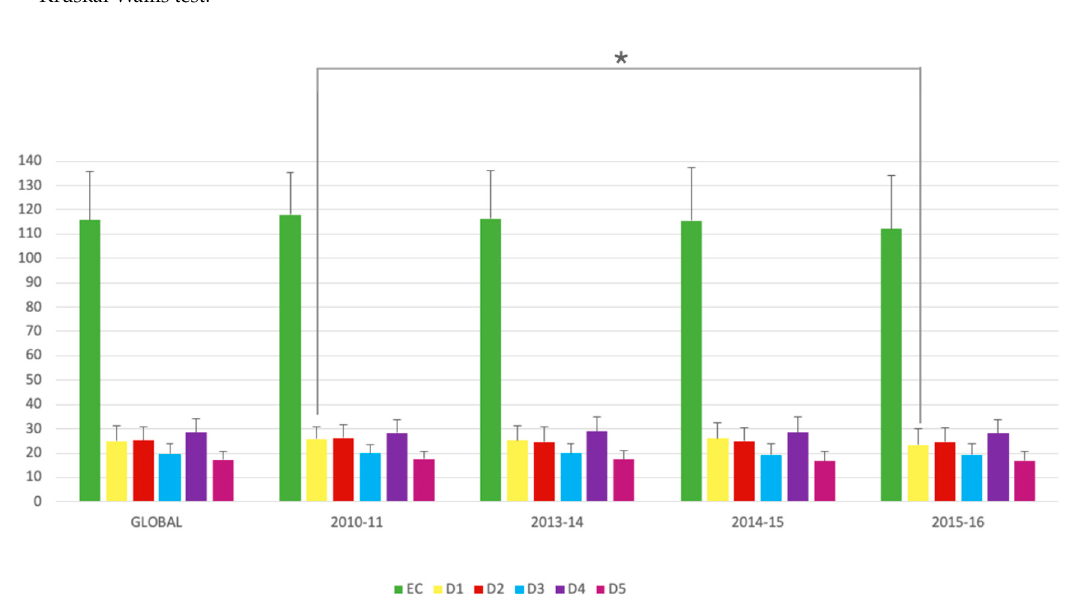
Figure 2. Means of scores and standard deviations for ‘Educational Climate’ and domains in the Dundee Ready Education Environment Measure (DREEM) questionnaire by academic years. * p -Value < 0.05.